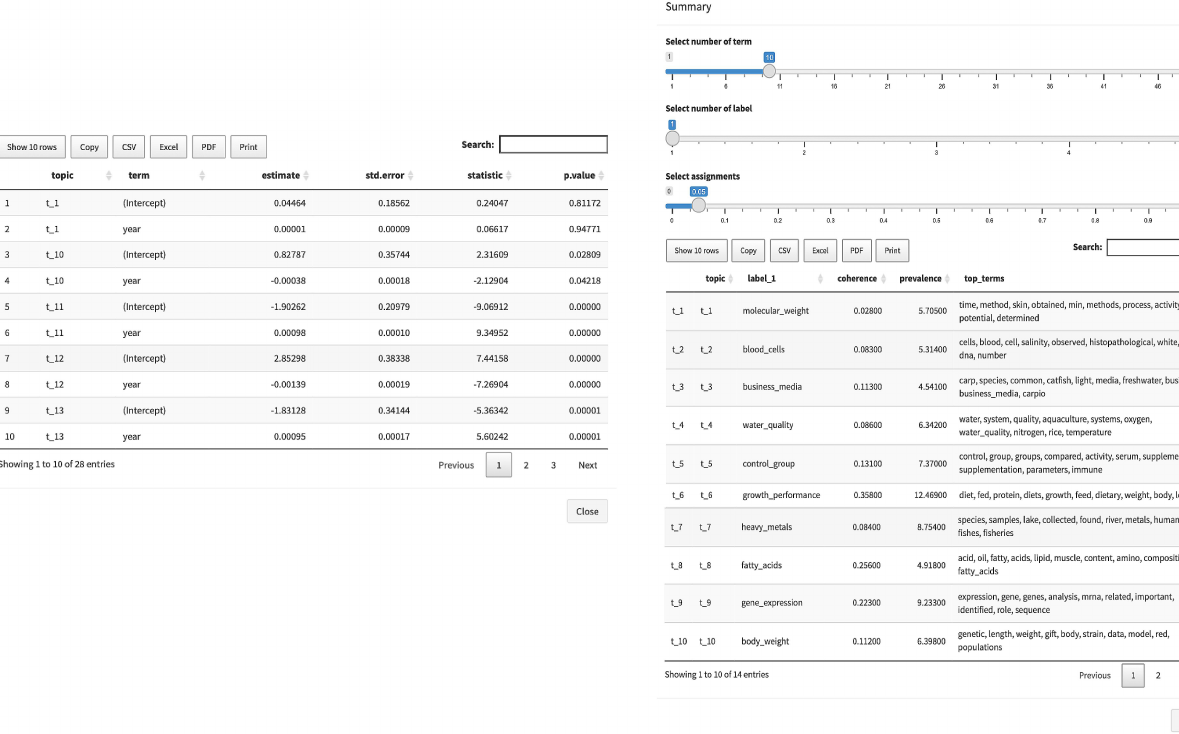
Figure 9. Output tabular of the model (theta and phi matrix).